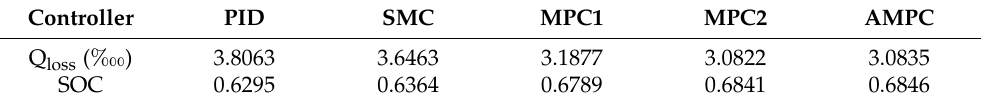
Table 7. Capacity loss value and SOC of battery under each controller after the WLTC (SOHini = 1).